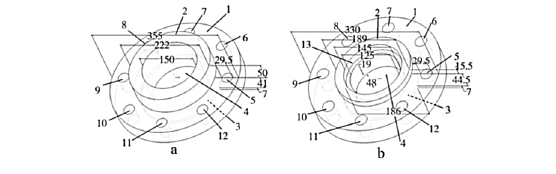
Figure 8. Matching judgment of flange